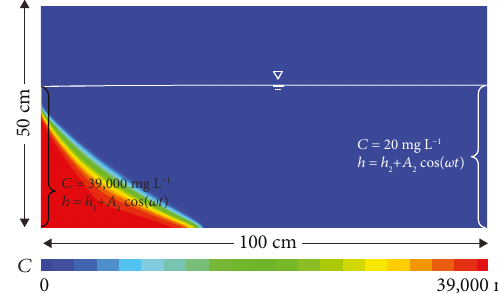
Figure 3: A numerical simulation of the steady state salinity distribution used as initial conditions. Boundary conditions are shown as